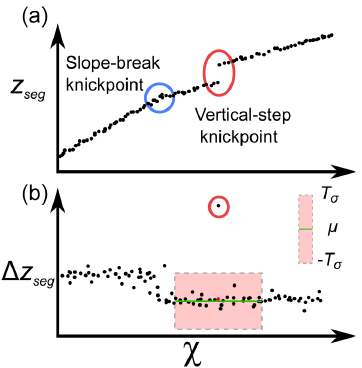
Figure 5. Extraction of knickpoints from the segmented elevation (Eq. 5). (a) Expression of a vertical-step knickpoint in a χ − z seg profile compared to a slope-break knickpoint. (b) Representation of the identification window and the corresponding standard deviation around the reference node (in red). µ is the mean and T σ the coeffi- cient applied to the standard deviation. This process is repeated for each node. Reference nodes outside their own window are consid- ered to be